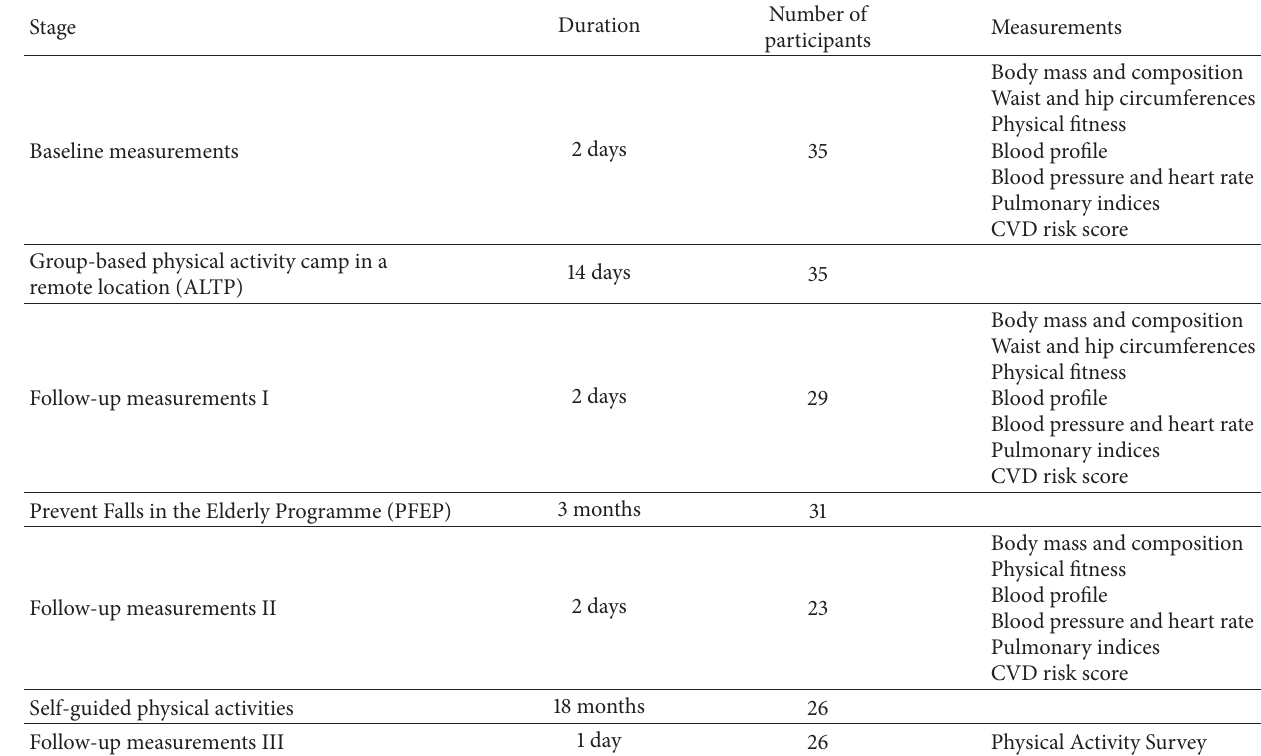
Table 2: Organization of the